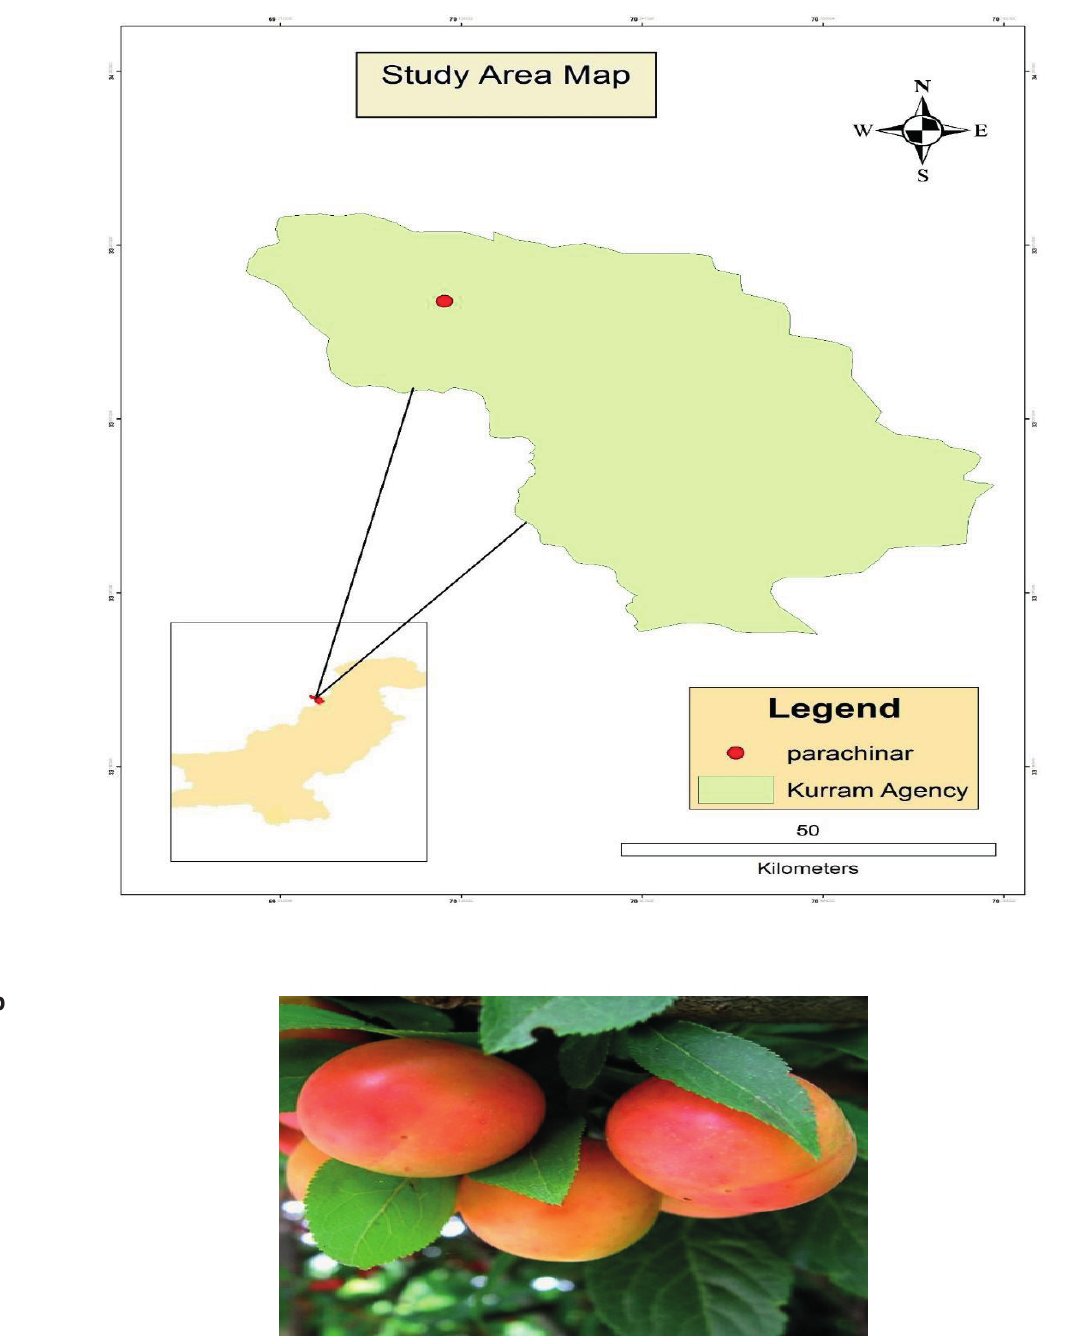
Figure 1: a) Map showing the administrative location of Parachinar, Kuram Agency, FATA, Pakistan and b) P. cerasifera